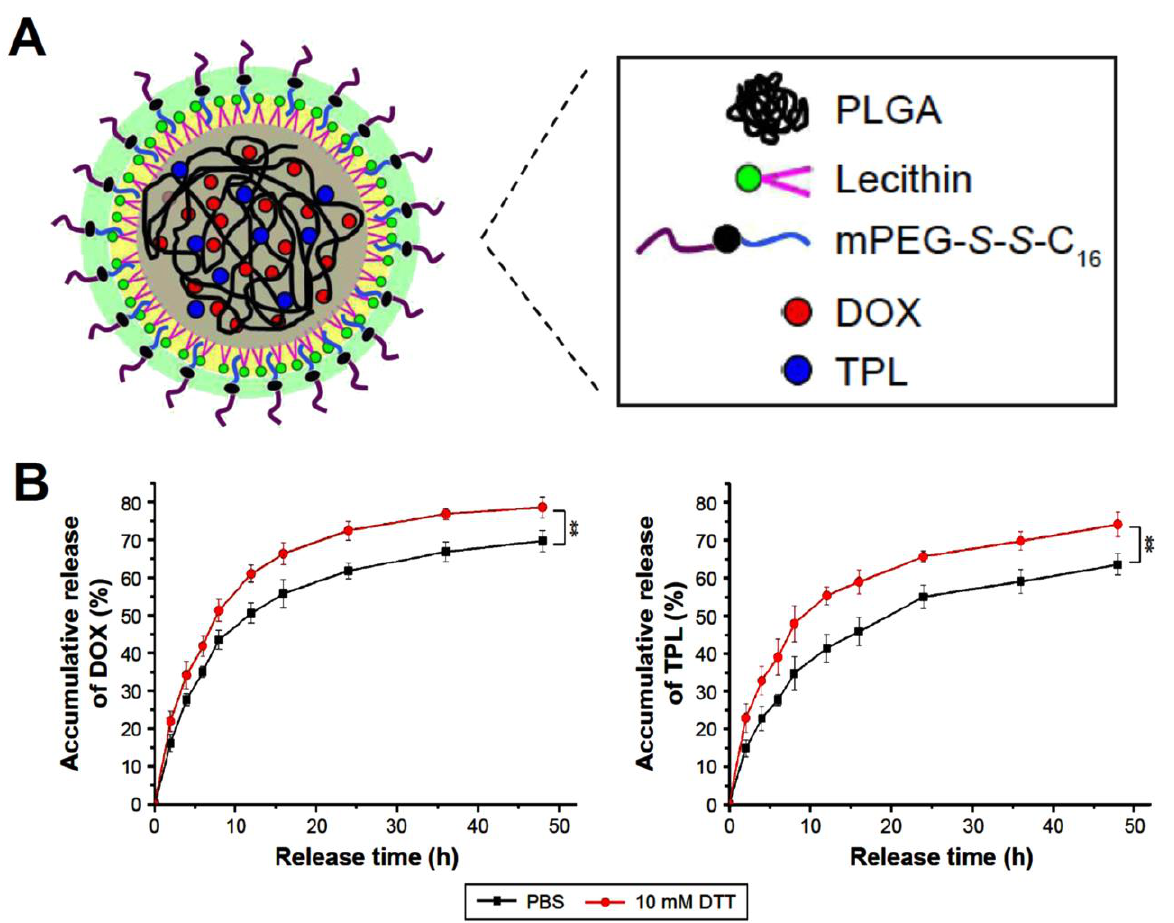
Figure 4. Lipid–polymer hybrid nanoparticles containing S-S bond sensitive to a reductive agents/environment. ( A ) LPNPs core–shell design including a hydrophobic core for loading of both TPL and DOX drugs. ( B ) Release profiles of DOX and TPL from DOX/TPL-1/0.2-loaded LPNPs in PBS at pH 7.4 in the presence of 10 mM DTT and in the absence of DTT (** p < 0.05). Reproduced from Wu et al. [119], International Journal of Nanomedicine 2017 12 1853-1862. Originally published by and used with permission from Dove Medical Press Ltd.